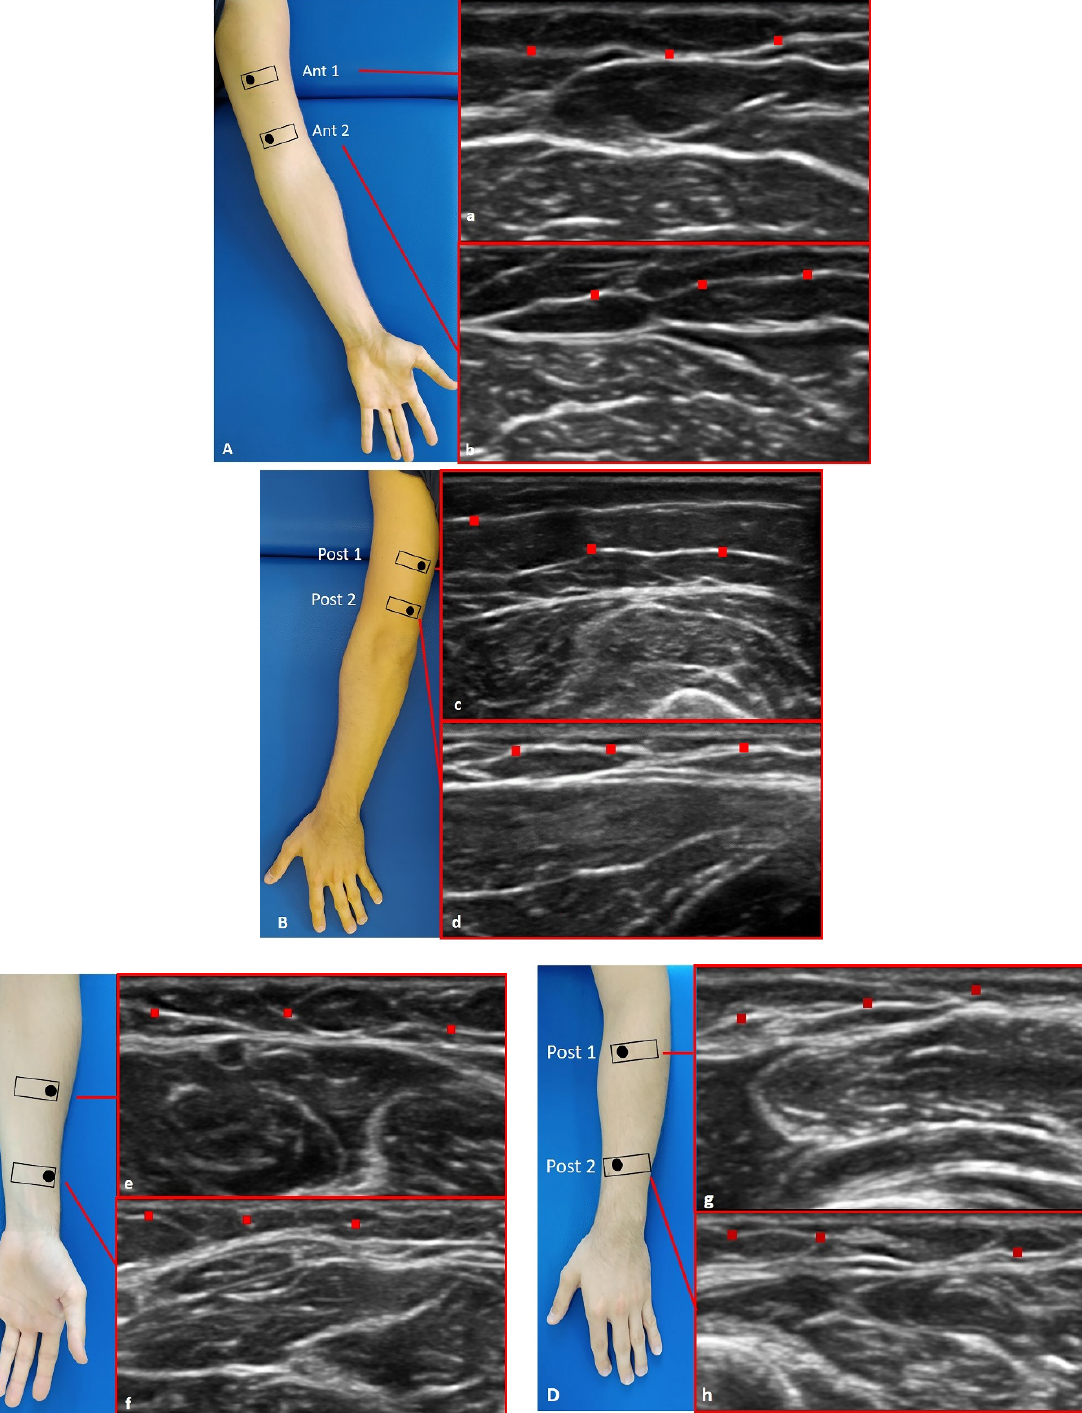
Figure 2. Ultrasound (US) images of the superficial fascia of: the anterior region of the arm ( A ) and of the forearm ( C ); the posterior region of the arm ( B ) and of the forearm ( D ). Anterior regions ( A , C ) at levels Ant 1 ( a , e ) and Ant 2 ( b , f ). Posterior regions ( B , D ) at levels Post 1 ( c , g ) and Post 2 ( d , h ). Probe: black rectangle; Red dashes: superficial fascia.